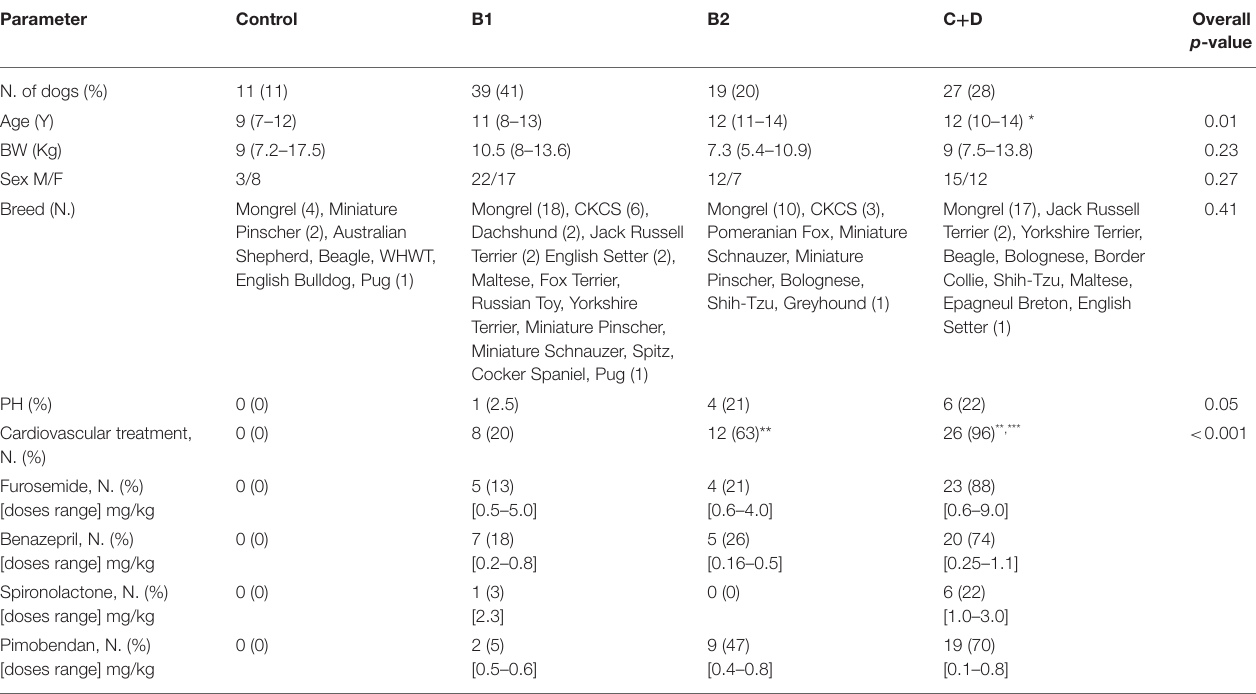
TABLE 1 | Clinical parameters of the 96 dogs included in the study.